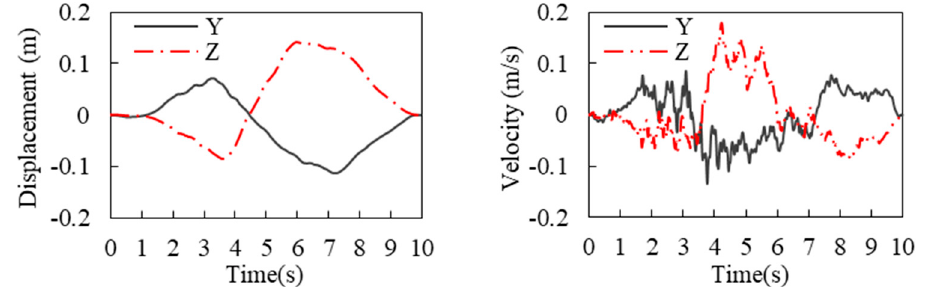
Figure 12. The Koyna earthquake displacement and velocity time history.